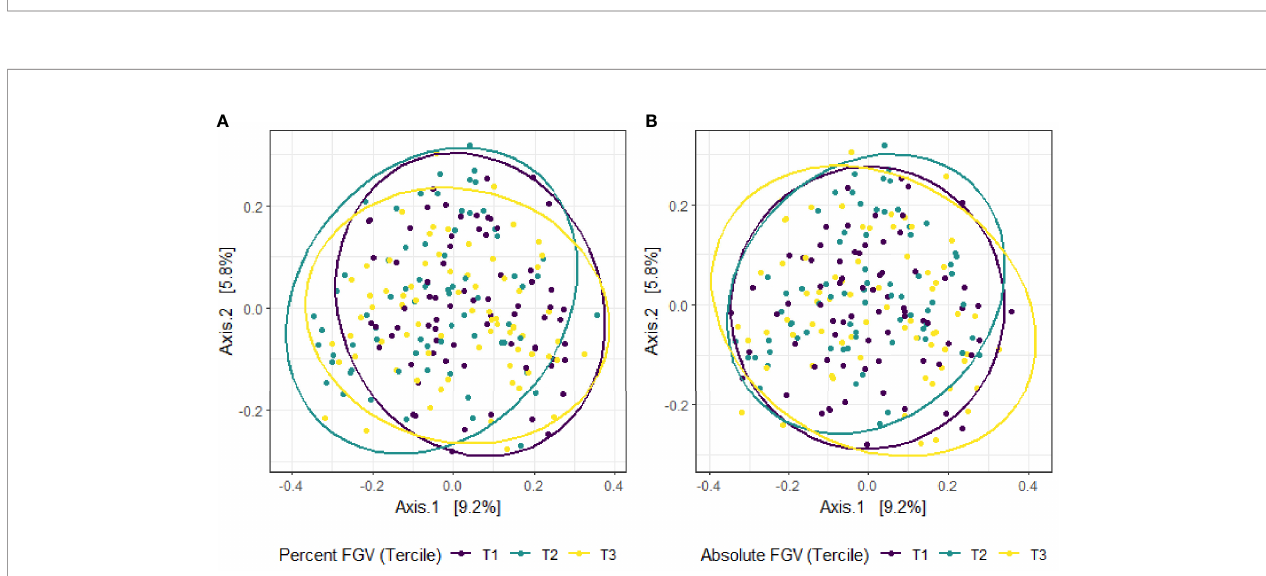
FIGURE 3 | Principal coordinate analysis (PCoA) plot of microbial composition derived from Bray-Curtis dissimilarity among fecal samples provided by 218 girls in GOCS colored by %FGV (A) and aFGV (B) terciles. Ellipses are 95% con fi dence regions for each